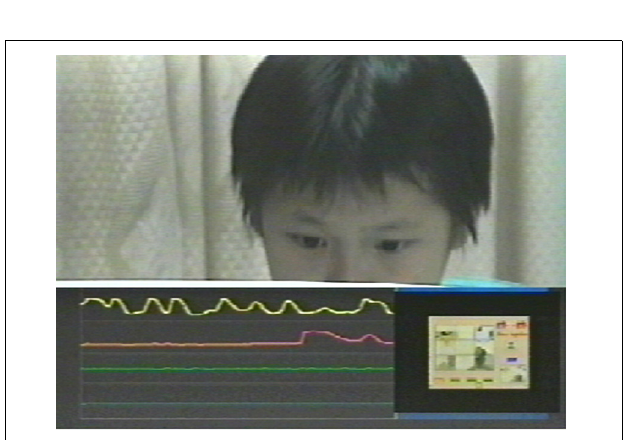
FIGURE 4 | A simultaneous recording of a learner’s creative learning process, psychophysiological response signals, and facial